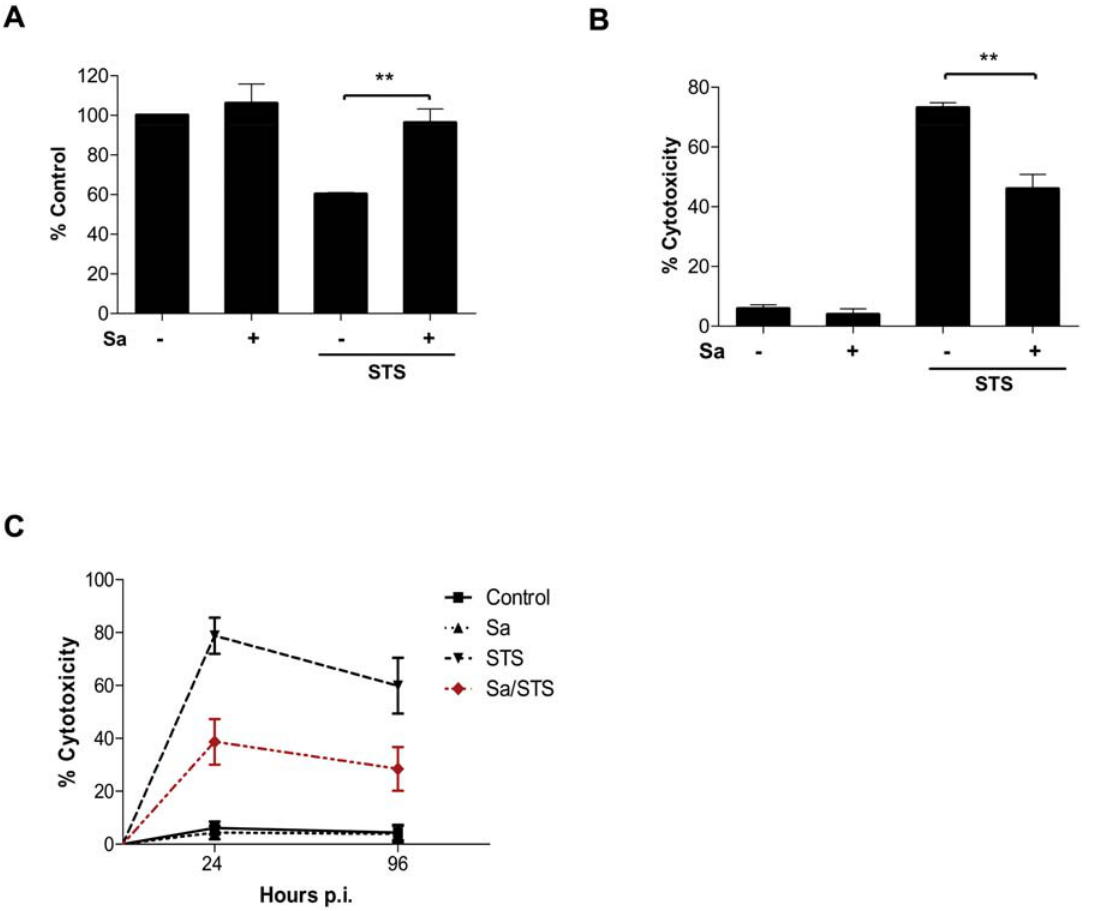
Figure 2. S.aureus -infected hMDMs show a decreased susceptibility to the cytotoxic effects of STS. Control and S. aureus -infected cells (24 h post-phagocytosis) were treated with STS at a concentration of 1 m M for 24 h and cell viability was evaluated by MTT (A) and LDH (B) assays. ( A ) The mitochondrial metabolic activity is presented as the percentage of control hMDMs, which were considered to be 100%. ( B ) Plasma membrane permeabilization or cell lysis induced in mock- and S. aureus- infected hMDMs was determined as LDH activity levels. The experimental value was the LDH activity in the conditioned medium from the control and infected cells after STS stimulation for 24 h. The data shown is representative of at least three separate experiments, performed in triplicate, using hMDMs derived from different donors. **, p , 0.01. ( C ) The cytotoxicity measured as the LDH activity levels in the conditioned medium from the mock- and S. aureus- infected hMDMs (24 and 96 h p.i.) after treatment with STS for 24 h. The data shown is representative of at least three separate experiments, performed in triplicate, using hMDMs derived from different donors. **, p , 0.01.